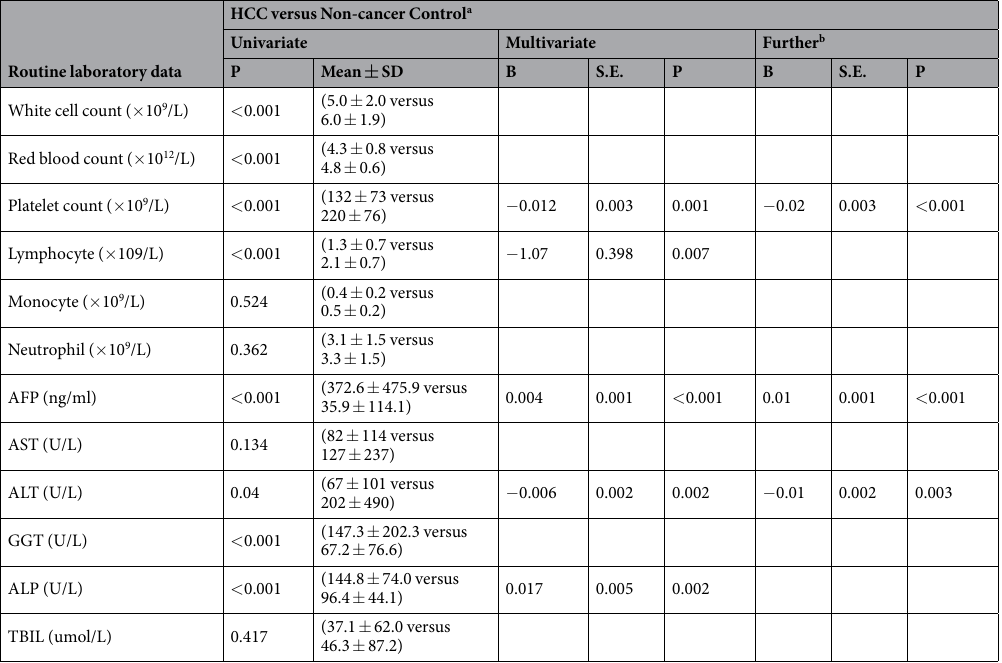
Table 2. Univariate and multivariate analysis of routine laboratory data in the training set associated with further analysis of risk factors. a Non-cancer Control group includes healthy participants and patients with CHB. b Further analysis means for simplification, the 5-variable panel was simplified to a 3-variable panel without losing accuracy after repeated